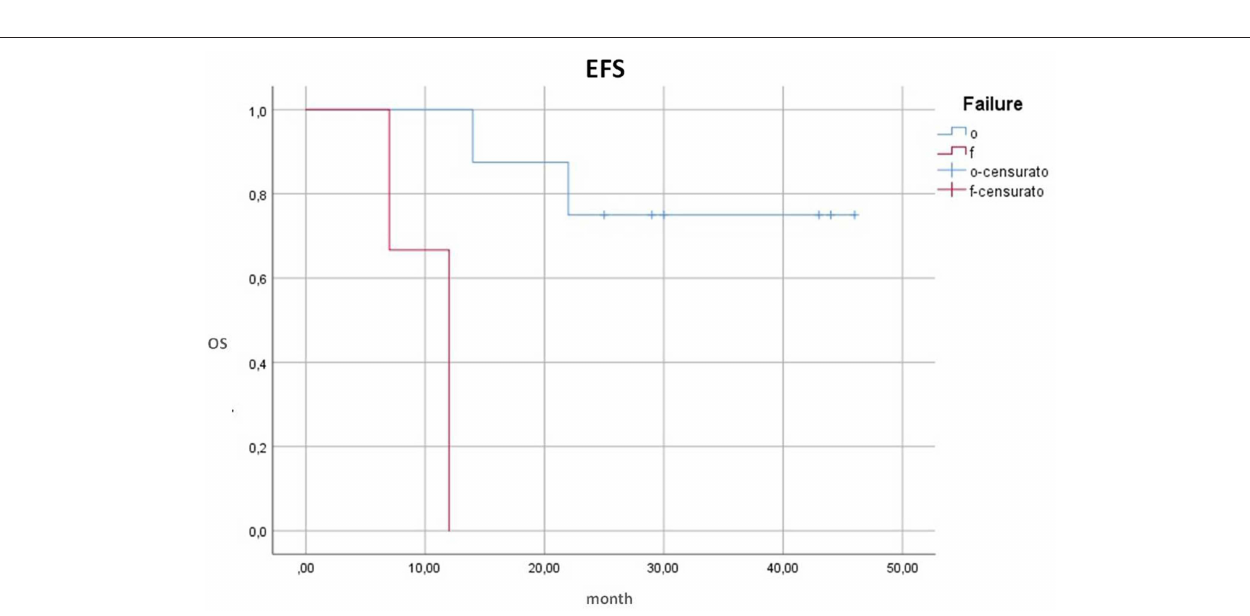
FIGURE 2 | EFS and up-regulation of WNT pathway. EFS, event-free survival; OS, overall survival; WNT up, overexpression of WNT genes; 38, low expression; 39, high expression. 100% of patients with a “low” up-regulation were event-free vs. 33% of those who presented a “high” up-regulation ( p = 0.05).